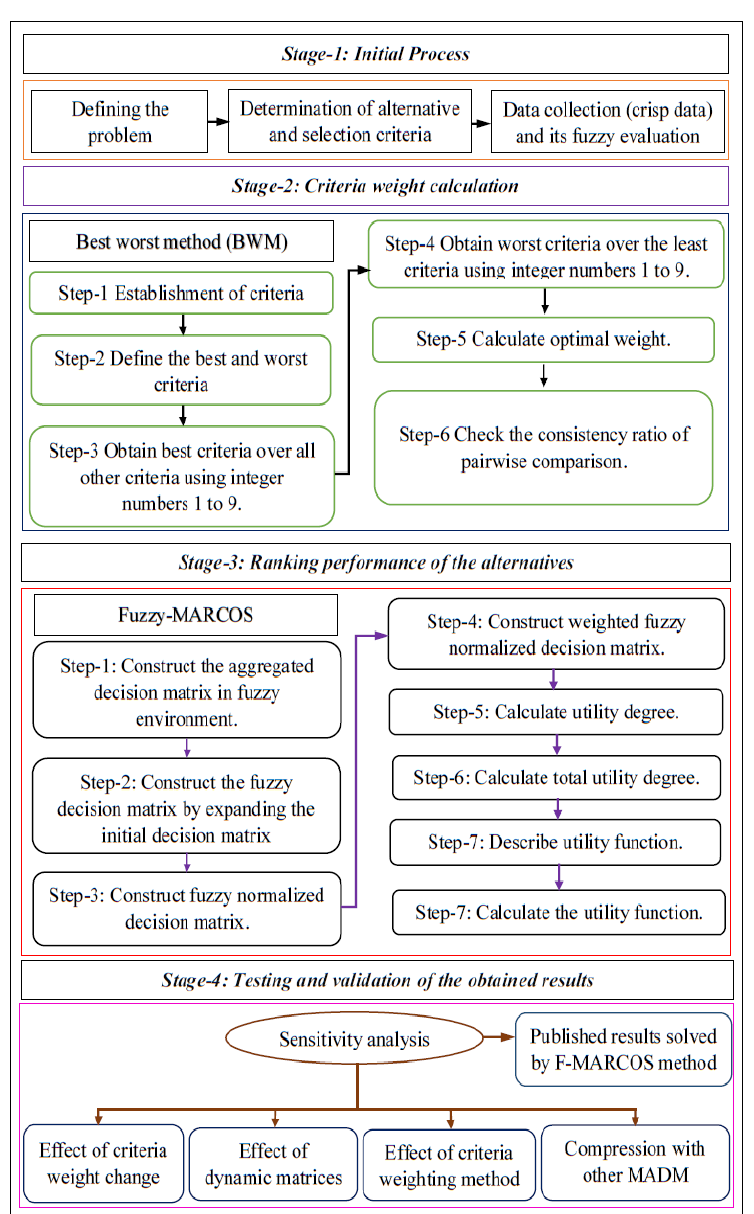
Figure 1. Algorithm of the proposed integrated BWM fuzzy MARCOS